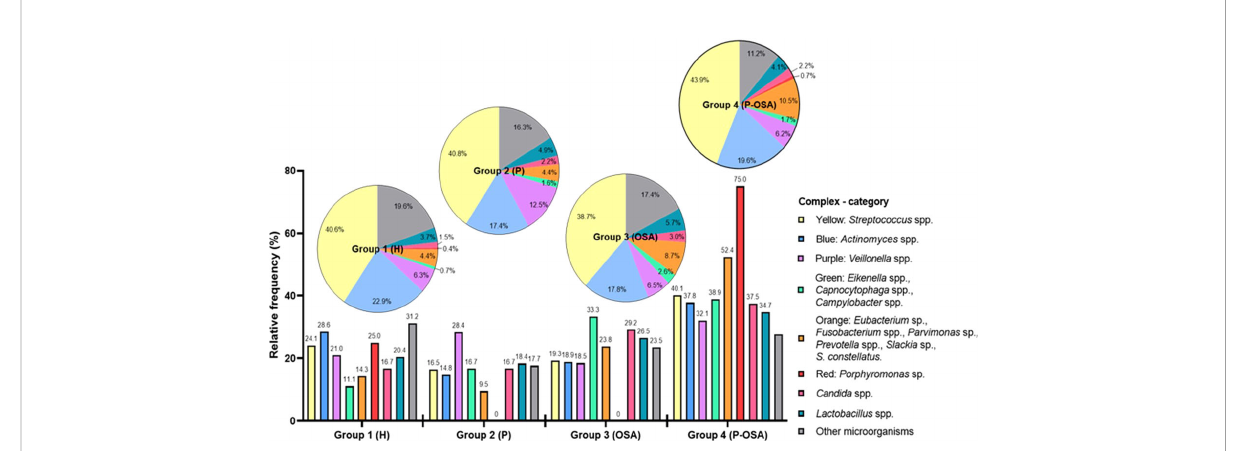
FIGURE 1 Microbial community composition is grouped by complexes or categories. Bars indicate the percentages of the inter-group relative frequencies of the complexes/categories in group patients. Pie charts show the intra-group distribution percentages of complexes/categories in group patients: Group 1 (H) healthy patients, non-periodontitis and non-OSA; Group 2 (P) periodontitis and non-OSA patients; Group 3: (OSA) OSA and non-periodontitis patients; Group 4 (P-OSA) periodontitis and OSA